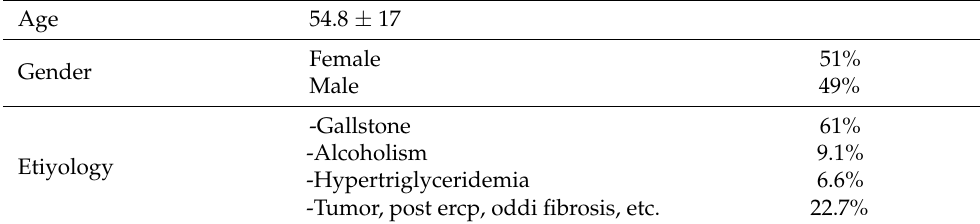
Table 2. Patient